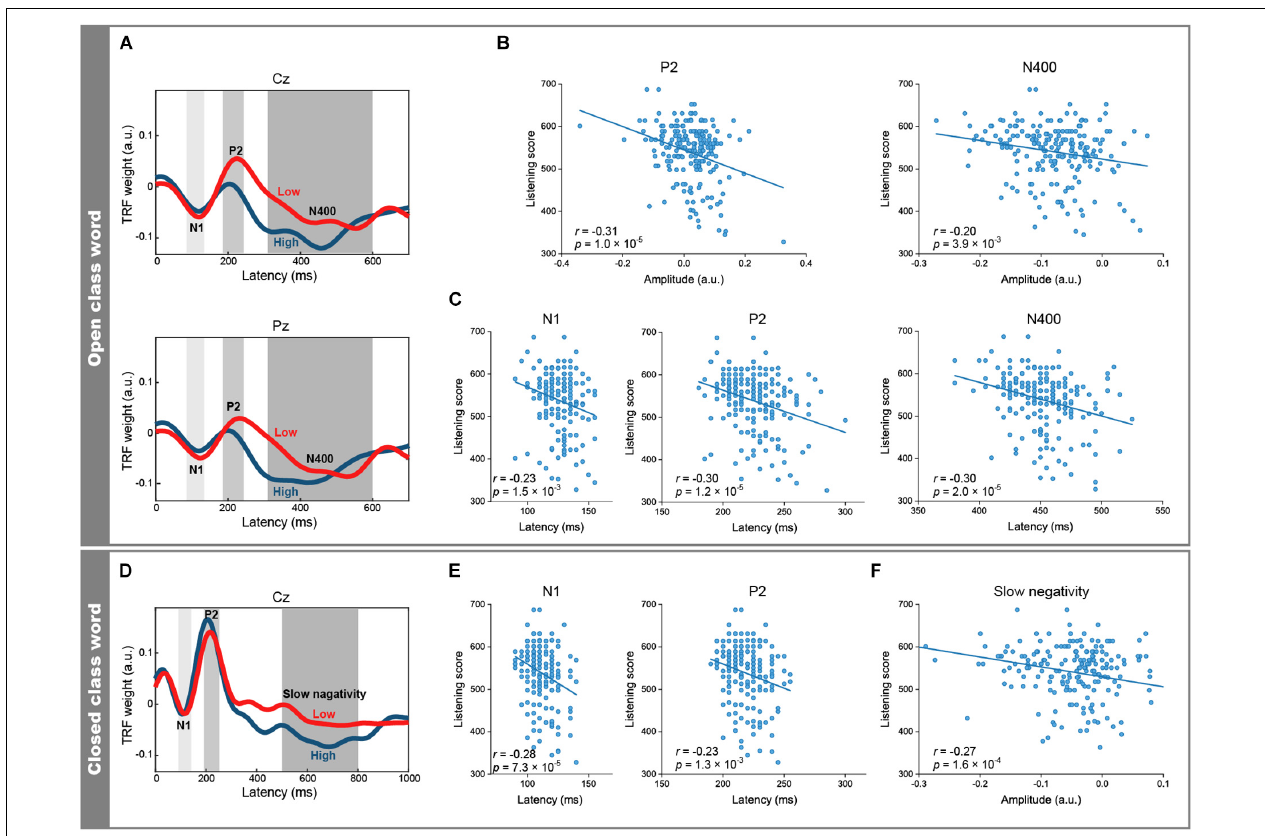
FIGURE 3 | Differences in TRFs between open and closed class words by English proficiency. (A) Grand-averaged TRFs for open class words across 49 participants with higher listening scores (blue) and across 51 participants with lower listening scores (red). The peak latencies of the N1, P2, and N400 components (Pz) were longer in the participants with lower scores (125, 230, and 530 ms, respectively) than those with higher scores (120, 200, and 420 ms, respectively). (B) The mean P2 and N400 (Cz) amplitudes of the open class words were negatively correlated with the listening scores. (C) The N1, P2, and N400 peak latencies (Pz) of the open class words were negatively correlated with the listening scores. (D) Grand-averaged TRFs for the closed class words (Cz) across 49 participants with higher listening scores (blue) and across 51 participants with lower listening scores (red). The peak latencies of the N1 and P2 components were longer in the participants with lower scores (115 and 215 ms, respectively) than in those with higher scores (110 and 205 ms, respectively). (E) The peak latencies of the N1 and P2 (Cz) of the closed class words were negatively correlated with the listening scores. (F) The mean amplitudes of the slow negativity (Cz) of the closed class words were negatively correlated with the listening